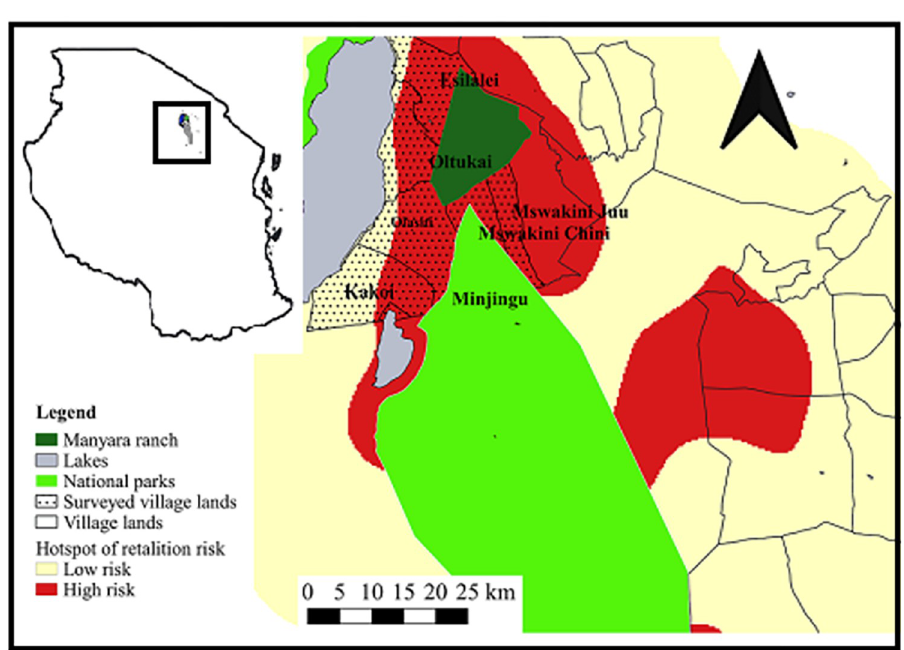
Fig 1. Location of the surveyed village lands, surrounding protected areas, heat map of high and low retaliation risk areas in TME. Protected areas are Manyara ranch- dark green color, National parks- light green color, lakes- grey color, surveyed villages lands- dotted black, high retaliation risk areas- red color, low retaliation risk areas- yellow color. Protected areas source shape files: Tarangire National Park Database, Villages surrounding protected areas source shape files: Tarangire Lion Project. ‘Republished from [ref] under a CC BY license, with permission from [Tarangire National Park] copyright [2018]’.